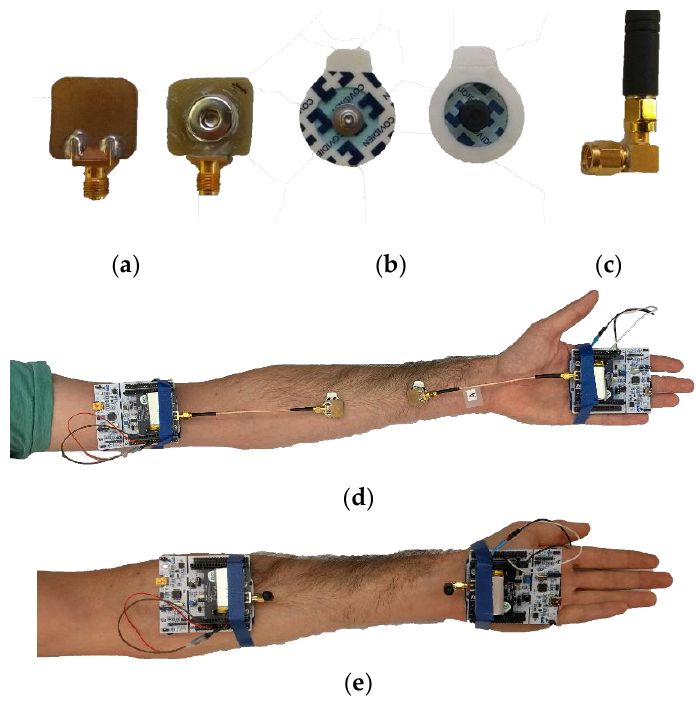
Figure 4. ( a ) BCC electrodes (connector part), ( b ) pre-gelled electrodes, ( c ) 450 MHz monopole antenna from the evaluation kit. ( d ) BCC on-body, ( e ) 450 MHz monopole antenna on-body.